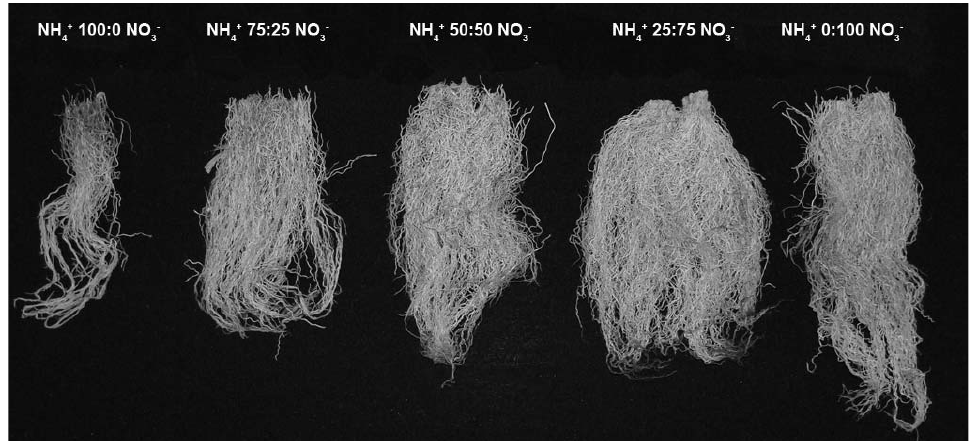
Figura 1. Desenvolvimento do sistema radicular do arroz IRGA 417 em função de proporções de N-NH 4+ e N- - em solução NO 3